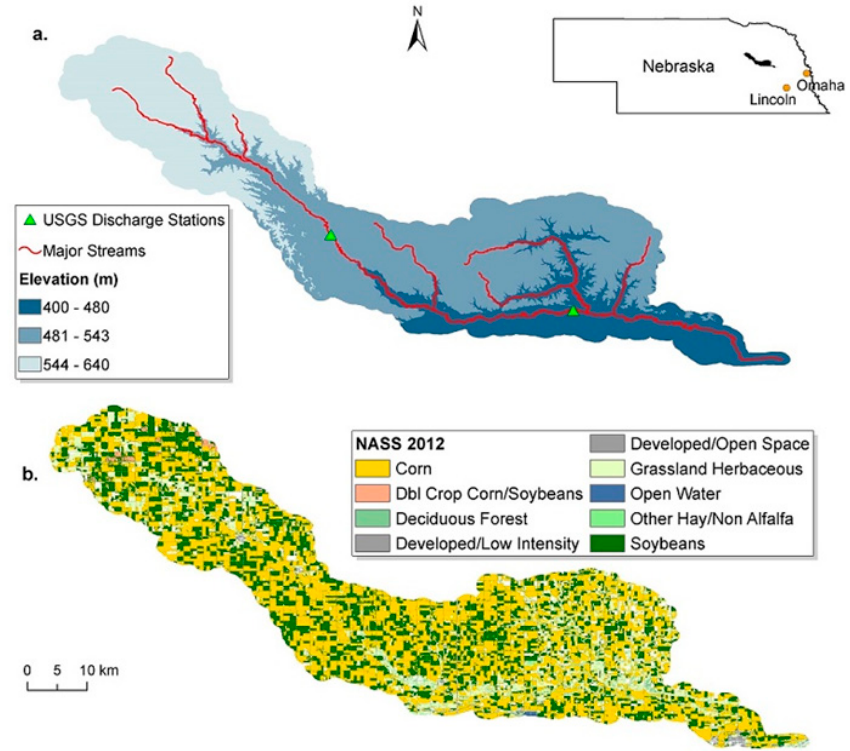
Figure 1. Shell Creek ( a ) streamflow network and ( b ) land uses. The watershed is home to heavily agricultural activities. Land cover types include cultivated (78.2%), herbaceous (14.6%), and forest (1.85%); while developed urban areas cover only 4.4% of the watershed. Corn (49%) and soybean (27%) dominates land use, with a high percentage of the cropland for irrigated row crops (46%) (Figure 1b and Sup- plementary Materials, Table S1). SC crop season onsets in spring–summer and depends on deep aquifer recharge or rainfed irrigation. The counties comprising the watershed include approximately 1550 farms with over 1,050,000 head of swine, cattle, and poultry [47]. Manure from livestock facilities is typically collected and land applied to agricultural fields as a soil conditioner and fertilizer. In this region, antibiotics are commonly admin- istered prophylactically for disease prevention as well as for disease treatment. Animals are typically raised in confined animal feeding operations (CAFO) where they are con- fined to production barns (swine and poultry) or feedlots (cattle). 2.2. Data 2.2.1. Rain Gauge Precipitation We used data from rain gages outside the SC watershed since no instruments follow- ing the World Meteorological Organization guidelines were found. Radar estimates to characterize the temporal variation and spatial distribution of precipitation were obtained from the National Oceanic and Atmospheric Administration (NOAA) Next Generation Weather Radar (NEXRAD). A total of 12 rain gages were identified with at least 100 year- long records (1910 to 2014). Ten stations belong to the National Climatic Data Center (NCDC) from the Global Historical Climatology Network (GHCN)–Daily database [48] and two to the High Plains Regional Climate Center (HPRCC). After screening quality data, stations with more than 90% of daily observations were kept, or otherwise